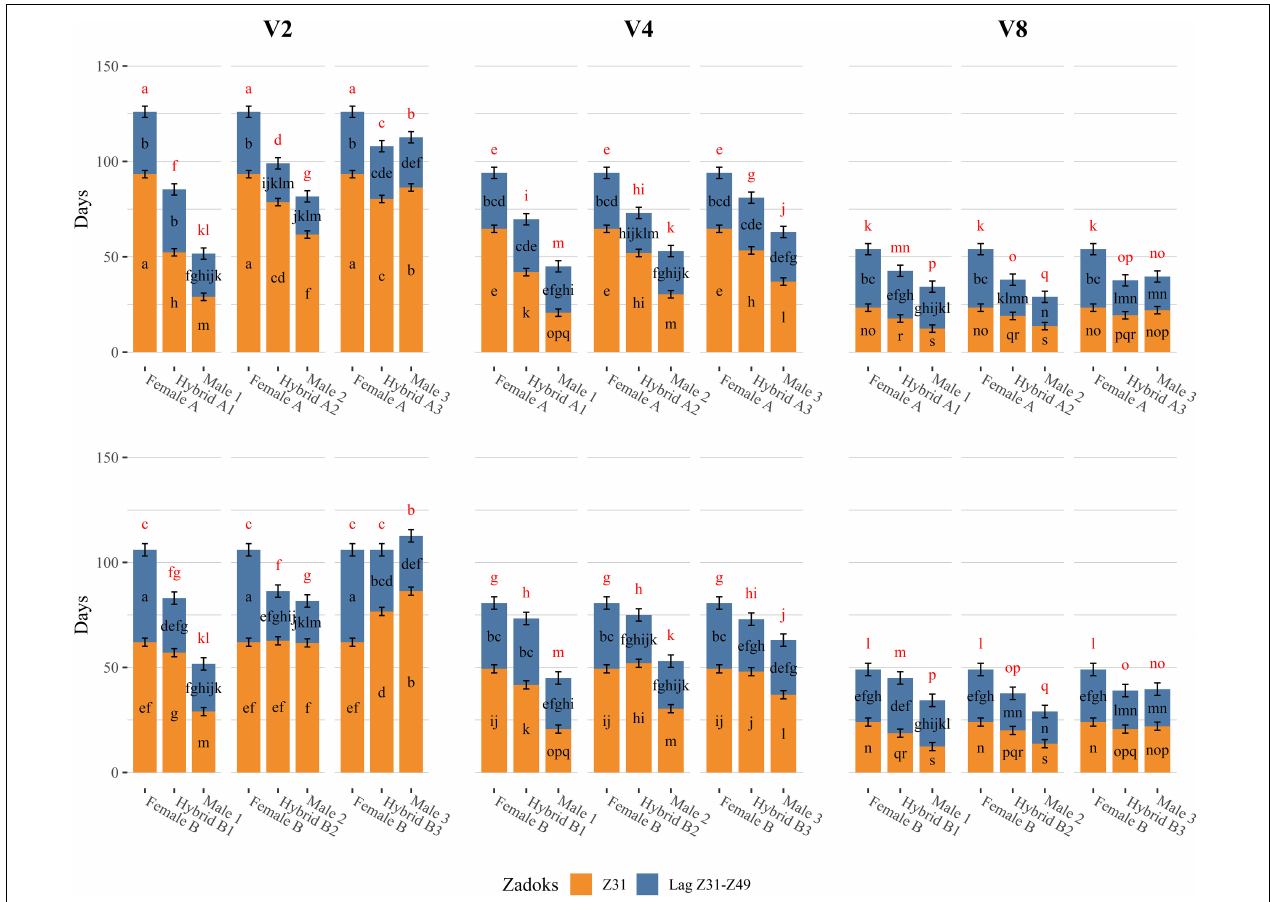
FIGURE 2 | Developmental differences of triads of genotypes (Female, Hybrid, and Male) grown under 16 h light, in response to different vernalization treatments (V2: 2 weeks of vernalization, V4: 4 weeks of vernalization, V8: 8 weeks of vernalization; 4–8 ◦ C, 8 h light). Days to first node appearance (Z31) are represented as the height of the orange bars, days to awn tipping (Z49) are represented as the total height of the bars, and the lag period between Z31 and Z49 (LagZ31–Z49) is represented as the segment in blue. Genotypes from Batch A are shown in the upper part of the graph, whereas genotypes from Batch B are shown in the bottom part of the graph. Each of the three columns of facets represents a vernalization treatment, low on the left, moderate in the middle, and complete on the right. Each subplot within each facet contains one triad of genotypes composed of one female parent on the left, the male parent on the right, and the hybrid in the middle. Error bars are 95% CIs for Z31 and LagZ31–Z49. For each developmental variable, bars with a different letter are significantly different at P < 0.05. Letters in red represent the comparison of the means for